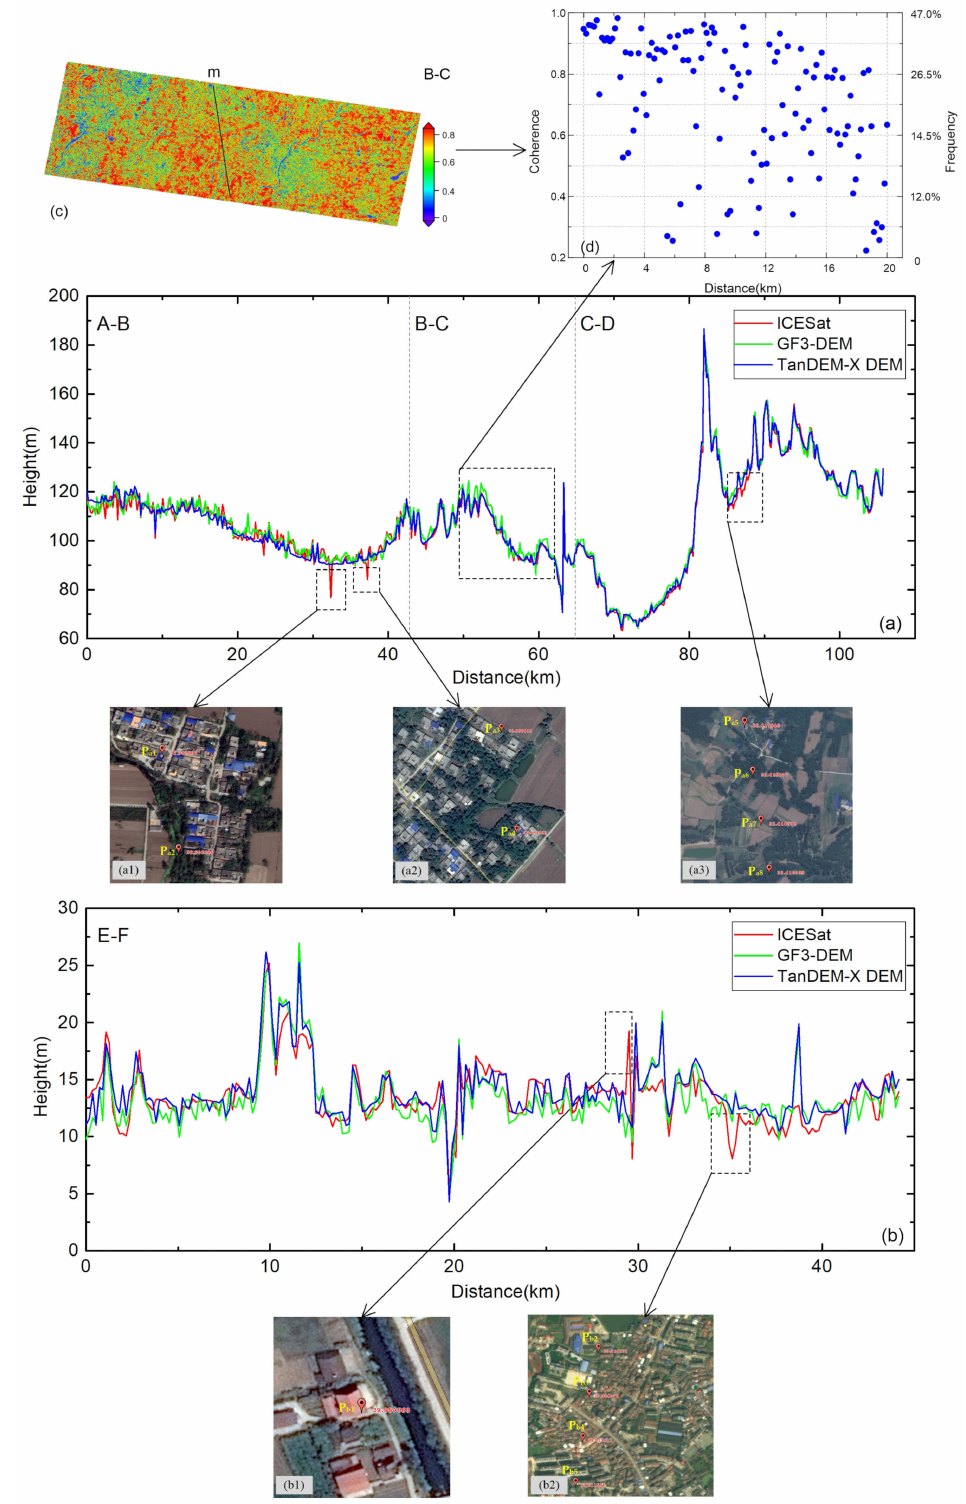
Figure 6. Elevation distribution maps of transects m and n : ( a ) the elevation change along section line m in interferometric pairs A–B, B–C and C–D; ( b ) the elevation change along section line n in interferometric pair E–F; ( c ) the coherence distribution maps of interferometric pair B–C; ( d ) the coherence distribution results of section line m . Panels ( a1 – a3 ) and ( b1 , b2 ) contain enlarged images of regions with abnormal ICEsat points; the labels P a1 –P b5 represent abnormal ICEsat